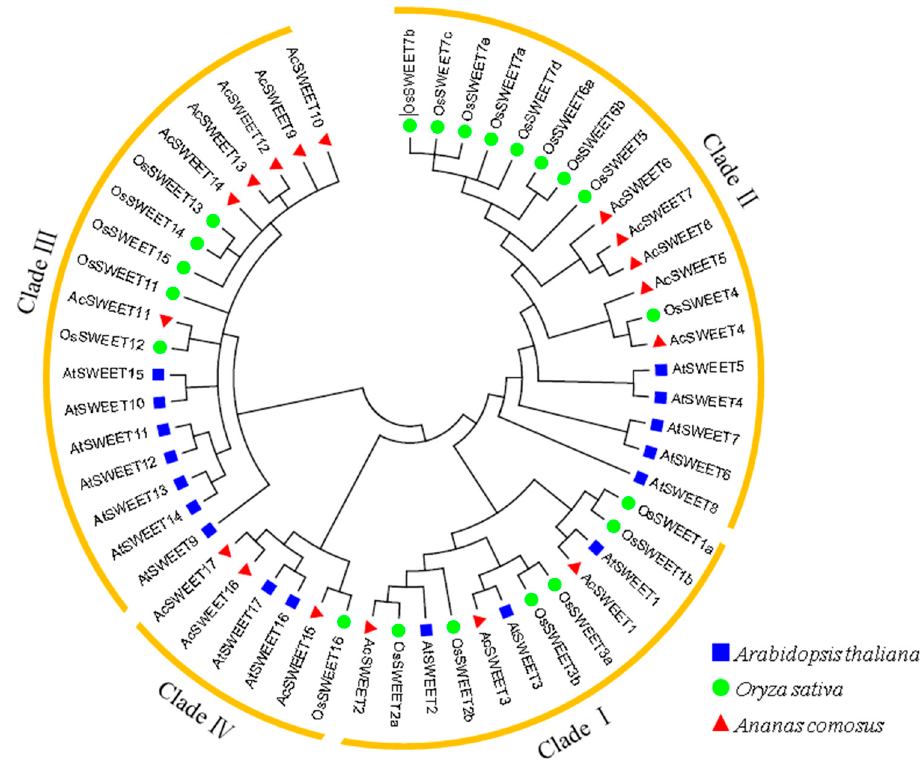
Figure 2. Phylogenetic tree of SWEETs from Arabidopsis , rice and pineapple. We used the neighbor-joining method to draw phylogenetic the tree with MEGA6.0 with 1000 bootstraps replicates. Four subgroups were divided as Clades I–IV.